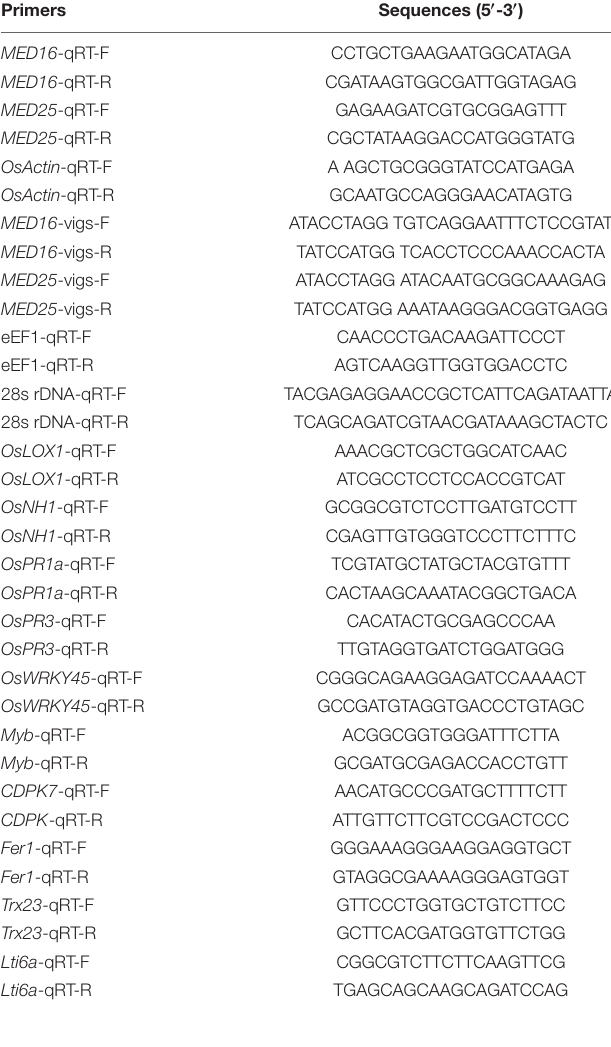
TABLE 1 | The list of primer sequences used in this